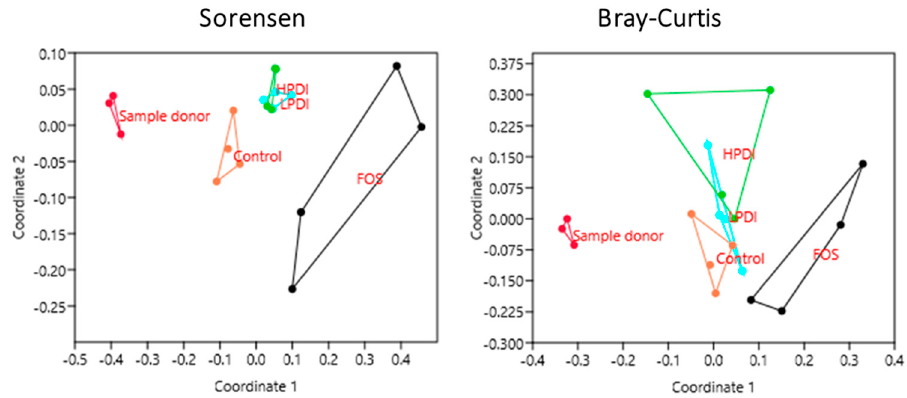
Figure 4. Clustering of samples based on nonmetric multidimensional scaling (NMDS) using the Sorensen and Bray–Curtis indexes at the genus level.